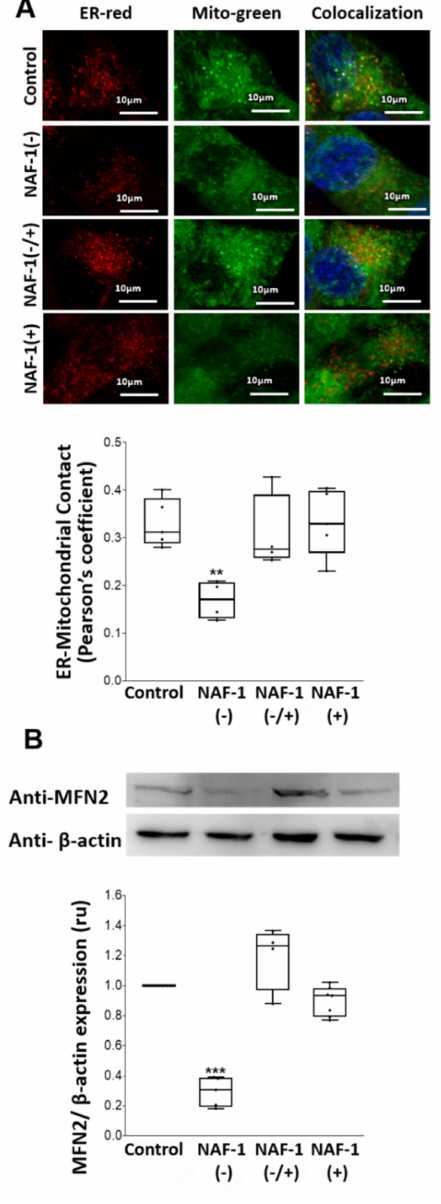
Figure 3. Quantification of ER-mitochondrial contacts using confocal microscopy and expression of MFN2 in INS-1E cells with repressed or overexpressed NAF-1 levels. ( A ) Representative confo- cal images of INS-1E control, NAF-1( − ), NAF-1(+), and NAF-1( − /+) cells co-expressing an ER-, mitochondria- and nucleus-targeted red, green, and blue fluorescent proteins, respectively (top). Yellow (green-red merged fluorescence) denotes contact points between the ER and the mitochondria. Quantification graphs showing the number of ER–mitochondrial contact points per cell (bottom). ( B ) Protein blots (top) and β -actin-normalized expression graph (bottom) showing MFN2 protein lev- els in INS-1E cells expressing different levels of NAF-1. The results are presented as box-and-whisker plots and include all data points measured in three different experiments. ** p < 0.01, *** p < 0.001, compared to control; Student’s t -test, N = 50. Abbreviations: MFN2, mitofusin